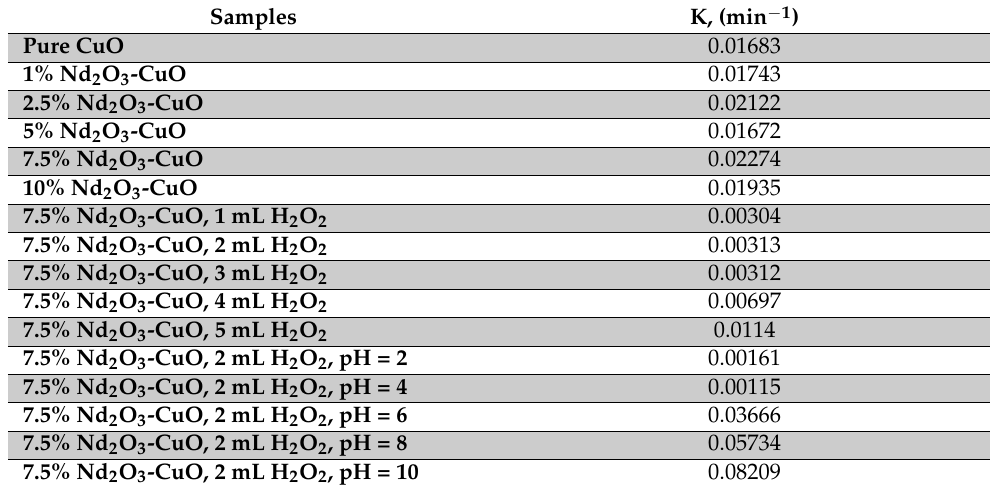
Figure 6. Rate constant values of MB dye photodegradation reaction in the presence of pure CuO and Nd 2 O 3 doped CuO NPs with different concentrations of Nd 2 O 3 . Table 4. The rate constants (min − 1 ) for all photodegradation. Samples K, (min − 1